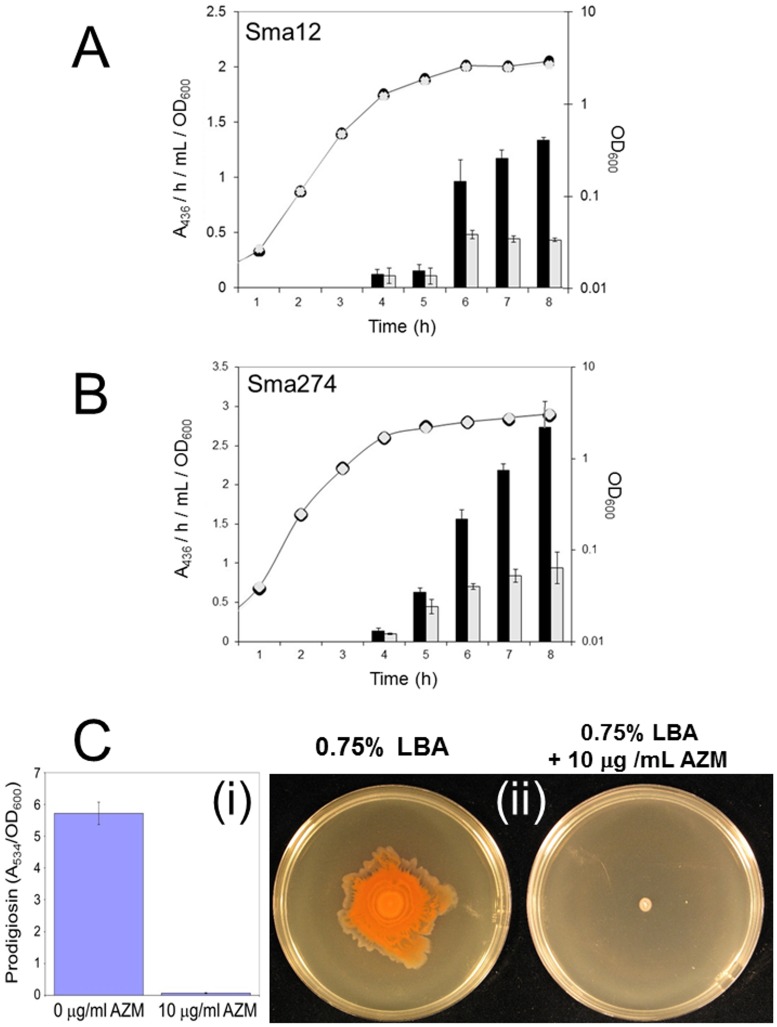
Impact of sub-MIC AZM on virulence phenotypes of Serratia marcescens.Secreted protease was measured through the growth curve of the QS+
Serratia marcescens strain Sma12 (panel A) and the QS- strain Sma274 (panel B) in the absence (black bars/symbols) or presence (grey bars/symbols) of 10 μg/ml AZM. Panel C; impact of 10 μg/ml AZM on (i) prodigiosin production in planktonic cultures of Sma274, and (ii) surface swarming by Sma274.